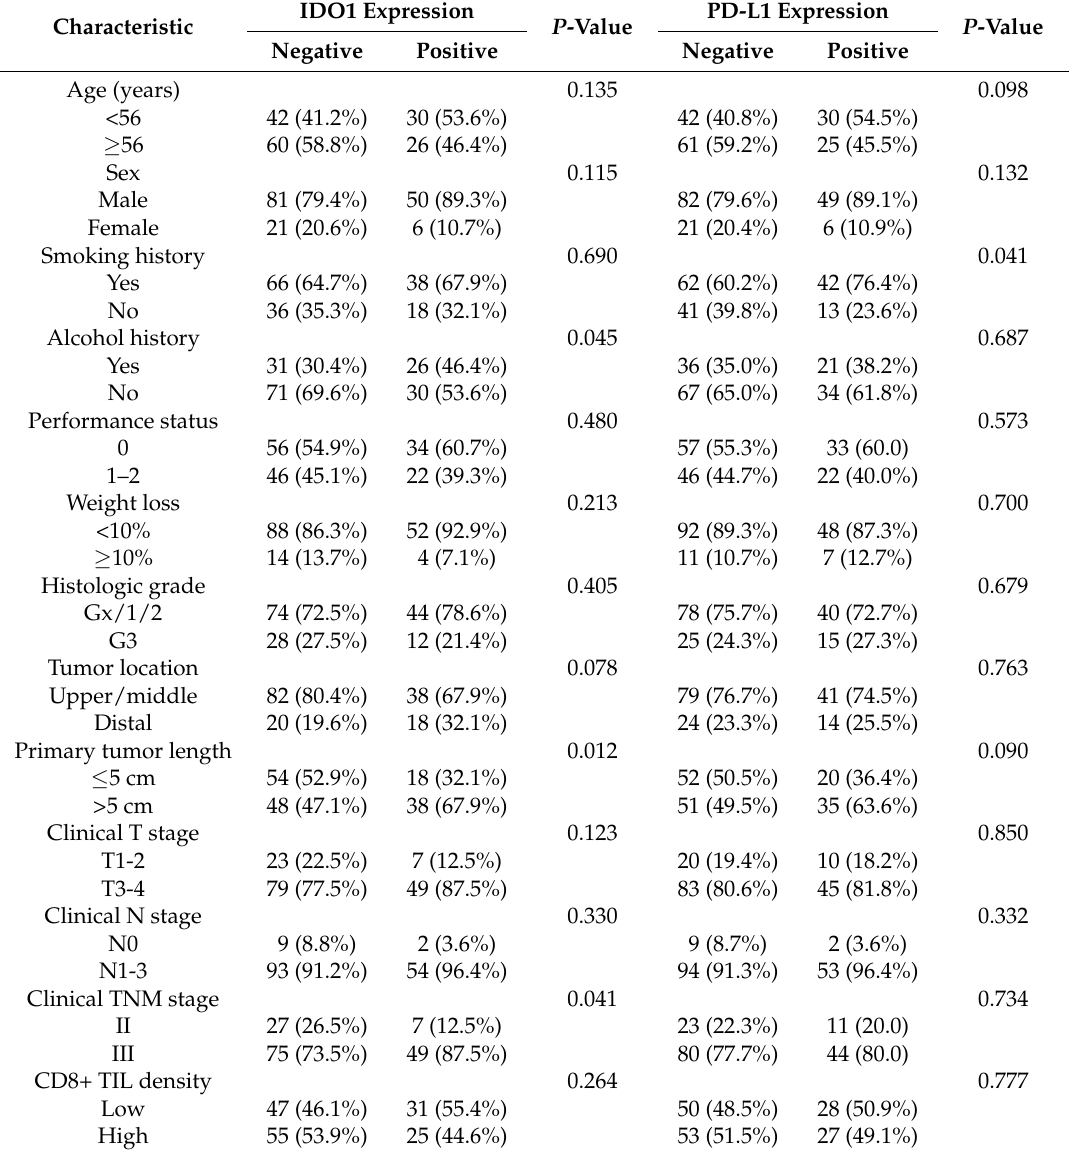
Table 2. Relationship between IDO1 and PD-L1 expression and patient clinicopathological